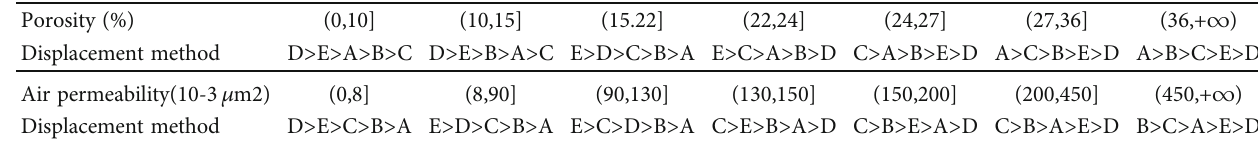
Table 3: Sequence of displacement methods with di ff erent porosity and air